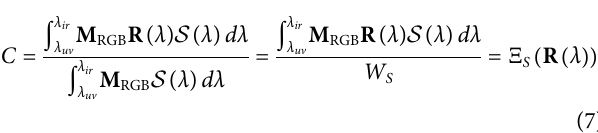
Frontiers in Computer Science |